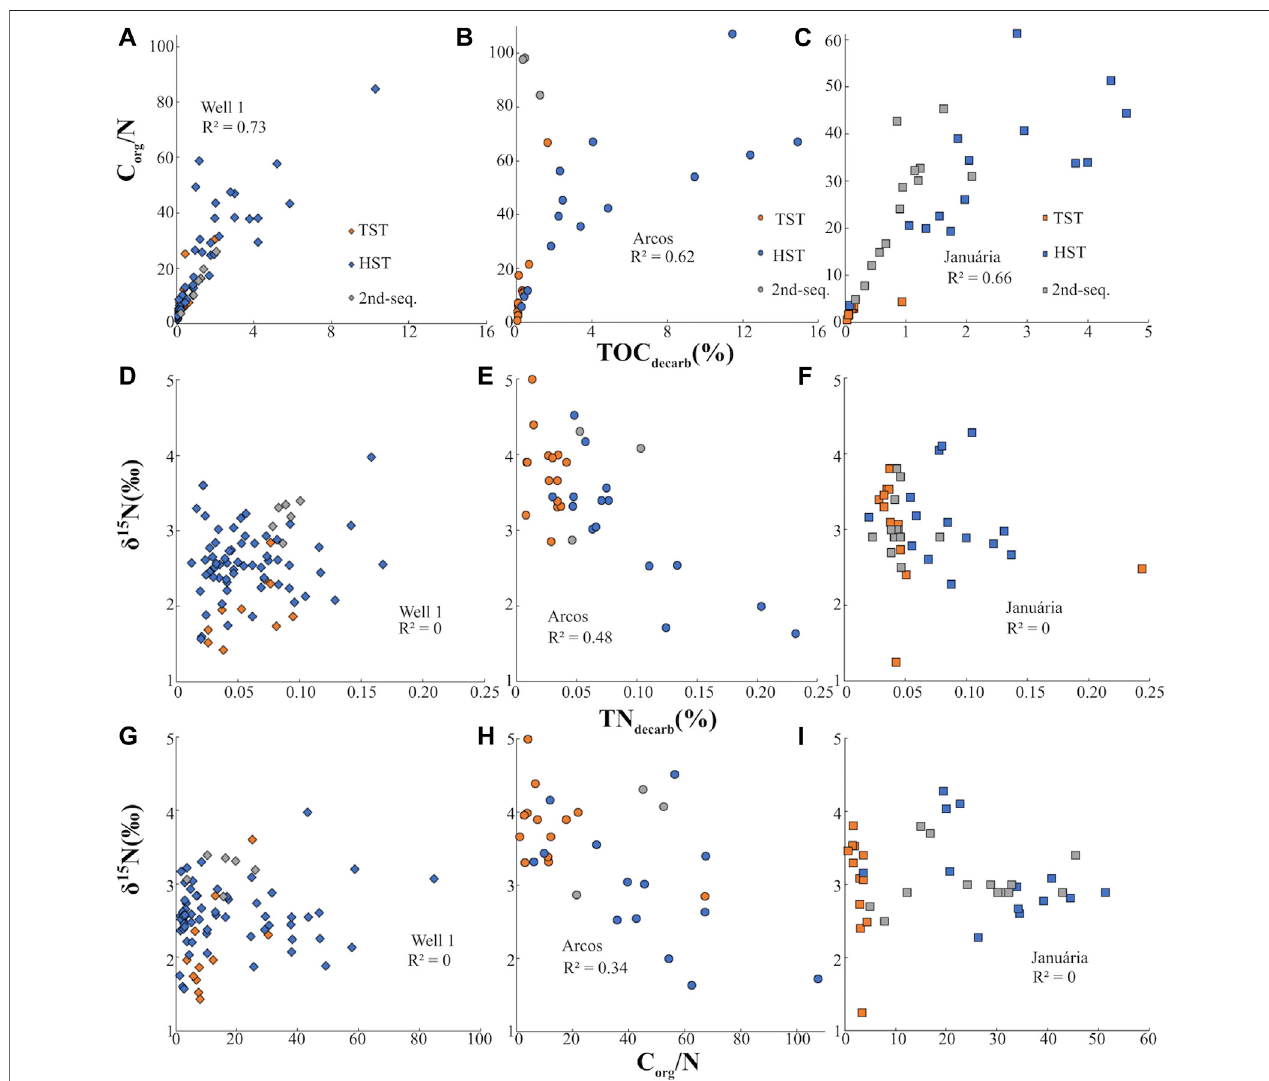
FIGURE 8 | Analyses of total nitrogen (TN), total organic carbon (TOC), C org /N and δ 15 N bulk in Well 1, Arcos and Janu (cid:1) aria sections.